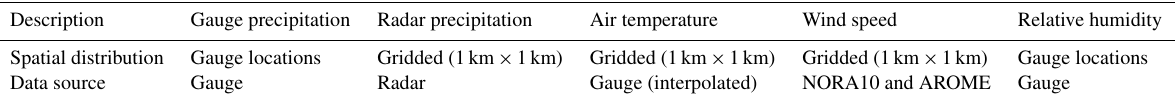
Table 1. Different datasets used in the study and their source and spatial distribution.